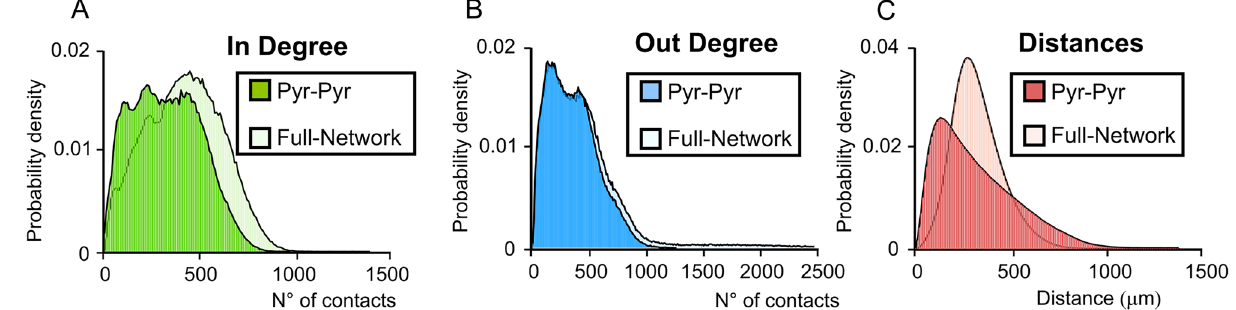
Figure 7. In-degree and Out-degree. ( A ) In-degree distribution shows the number of incoming inputs received by a single neuron expressed as a probability density. The degree distribution for the full network shows that there are about 500 incoming inputs on average. The in-degree distribution for solely excitatory cells is left shifted towards lower values. ( B ) The out-degree distribution represents the number of cells contacted by a single neuron in the network expressed as a probability density. In this case, including inhibitory synapses in the network leads to an enlargement of the curve rather than to a shift, since the peak value is left almost unchanged. ( C ) The connection length distribution shows a shape similar to that determined by experimental and computational studies 20 .